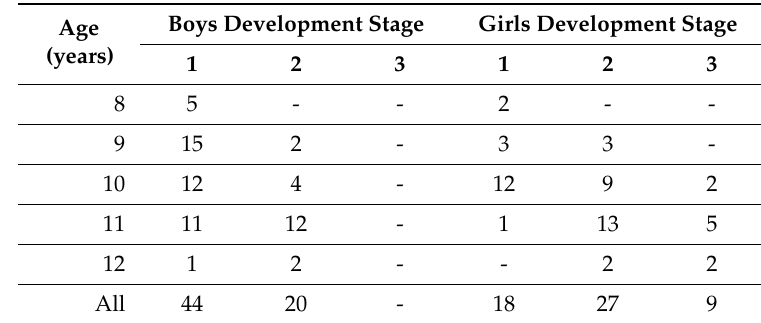
Table 2. Maturational distribution of